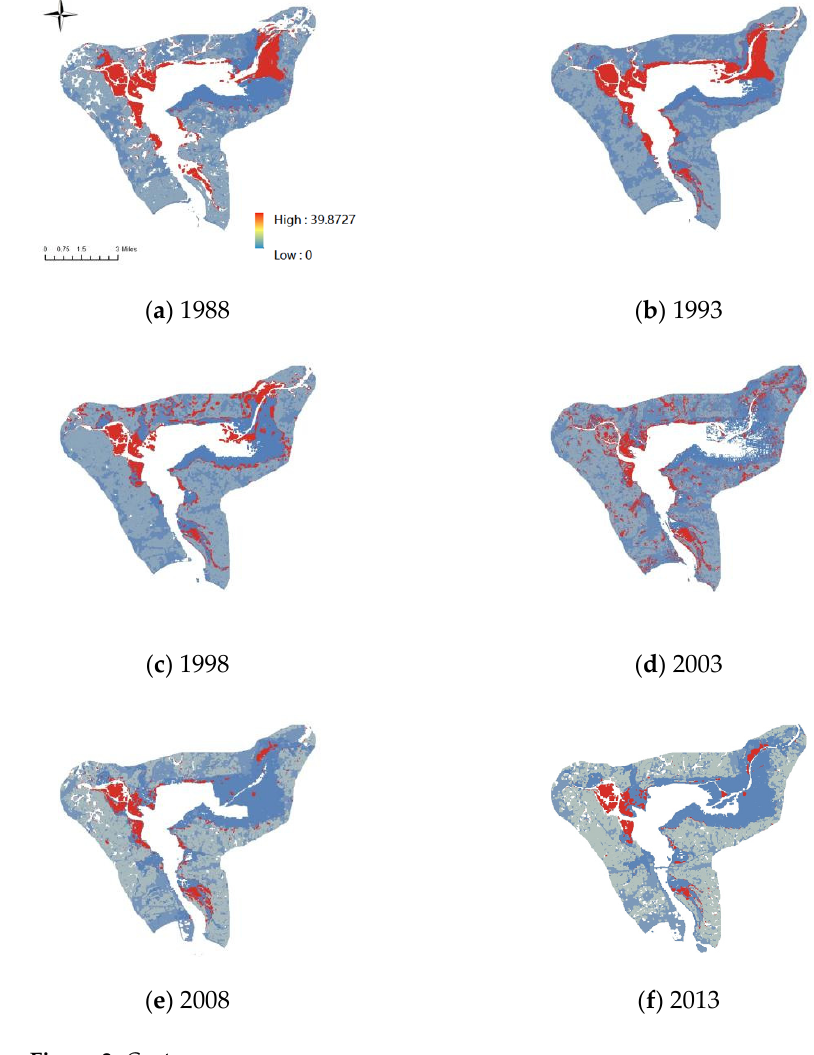
( h ) 2020 Figure 3. Spatial distribution of carbon stock in the coastal zone in Hainan Province from 1988 to 2020